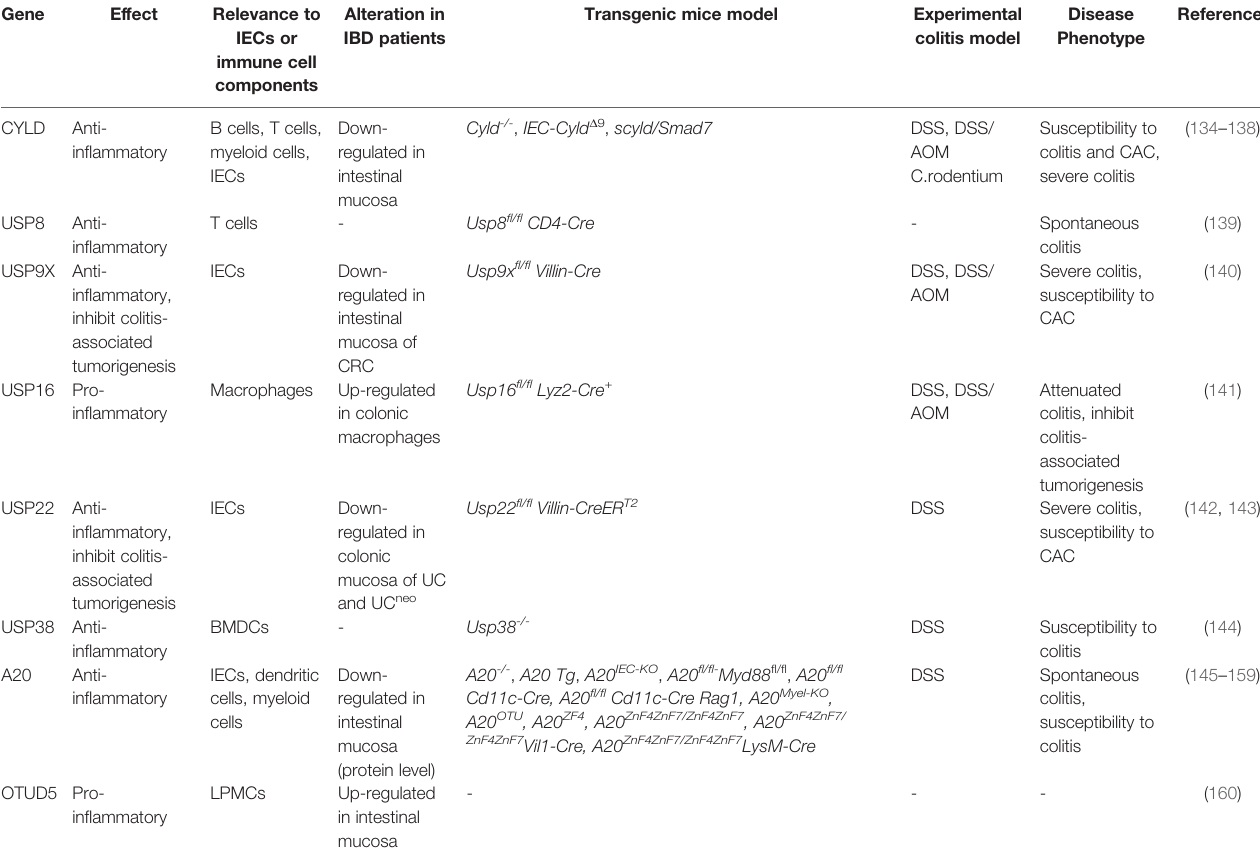
TABLE 2 | Role of DUBs in in fl ammatory bowel